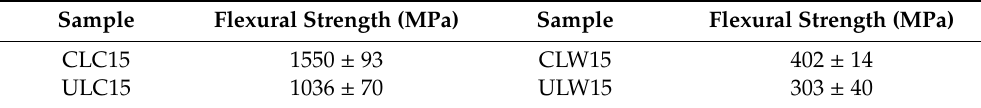
Table 3. Bending strength of the CLC15, CLW15, ULC15 and ULW15 samples.